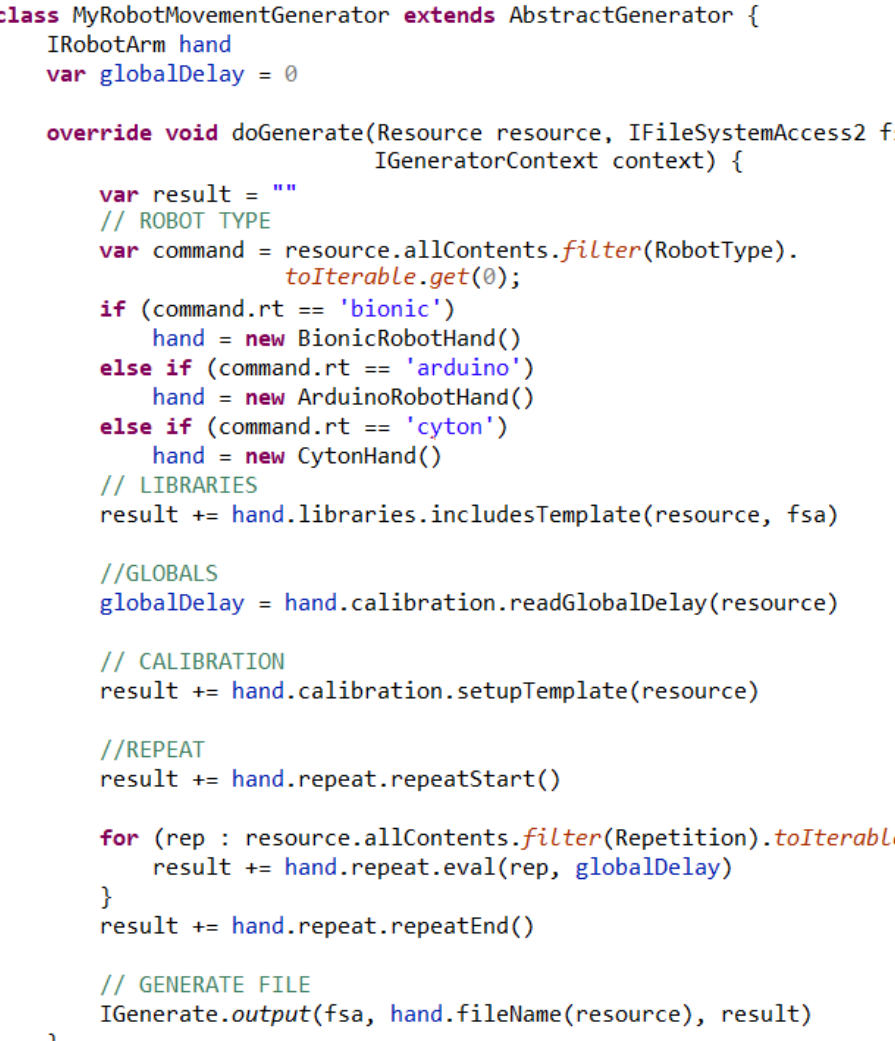
Figure 6. Generation of the